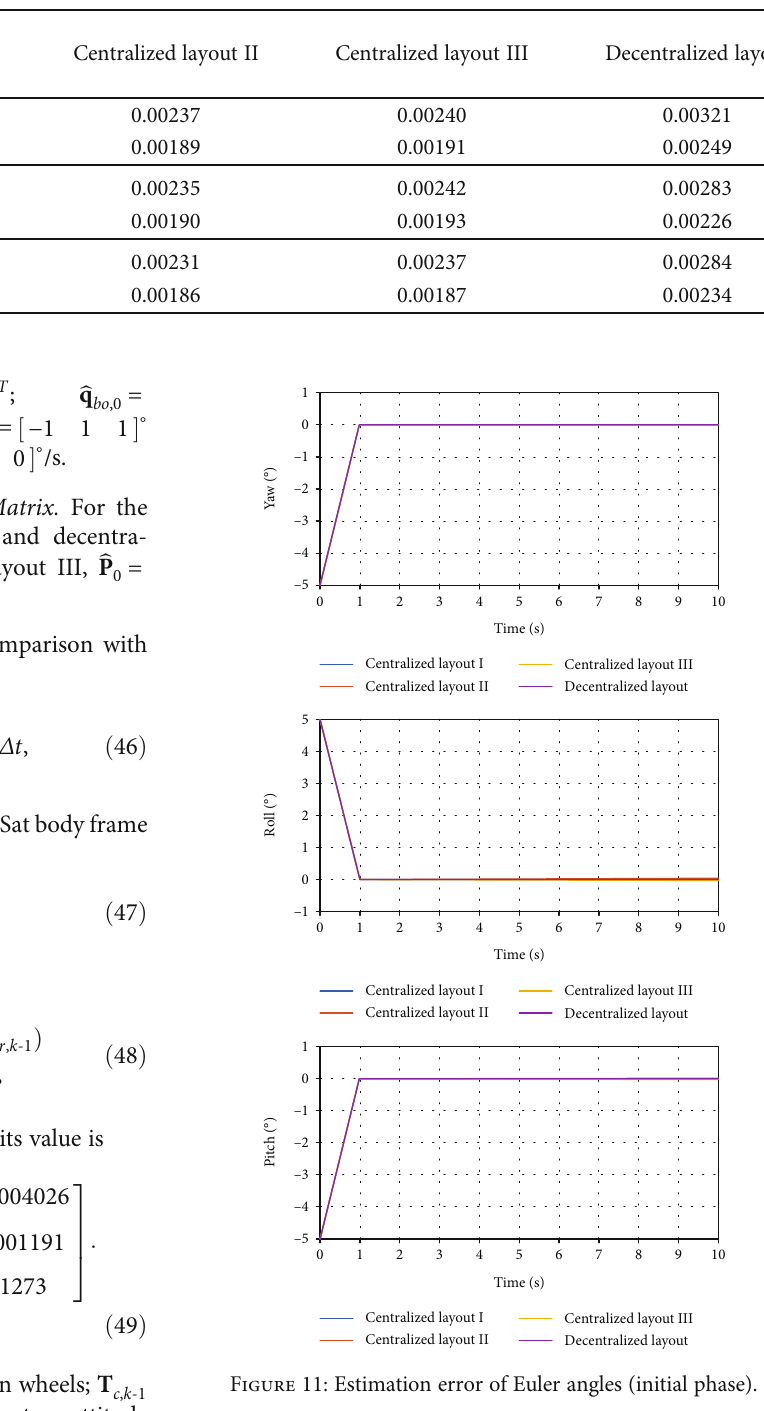
Table 3: RMSE and MAE of estimation error of gyro biases.